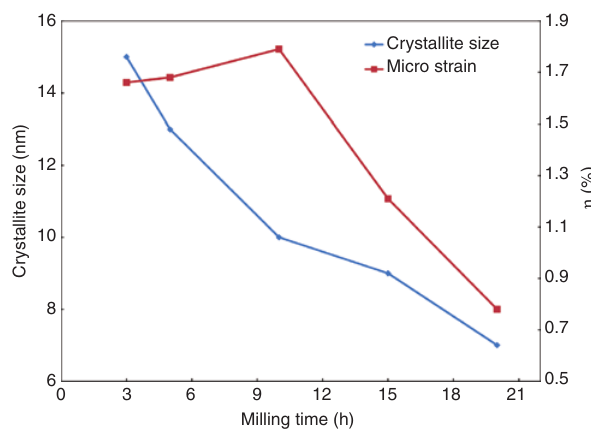
Figure 6: Variation of crystallite size and strain in the Fe-TiC system by milling time.